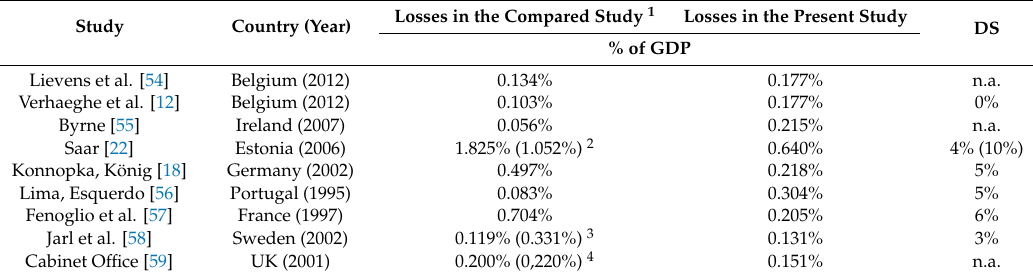
Table 4. Comparison of production losses associated with mortality in selected studies from the European Union (2000 and